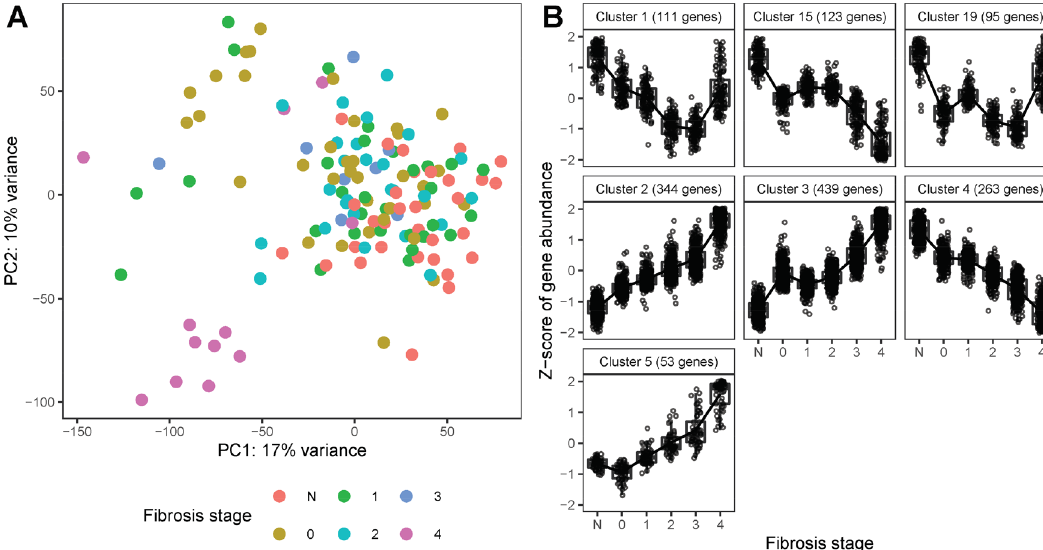
Figure 1. RNASeq analysis. ( A ) PCA plot of all samples. Colors represent different fibrosis stages, where N corresponds to the Normal group. ( B ) Gene expression patterns of DE genes. The Z-score represents the scaled transformation of the log2 normalized counts. Only clusters with more than 50 genes are